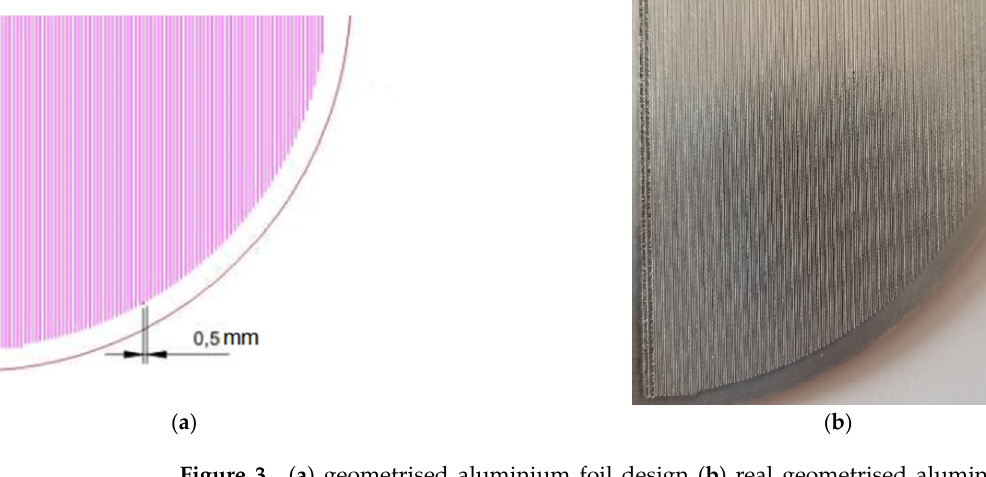
Figure 3. ( a ) geometrised aluminium foil design ( b ) real geometrised aluminium mould used for